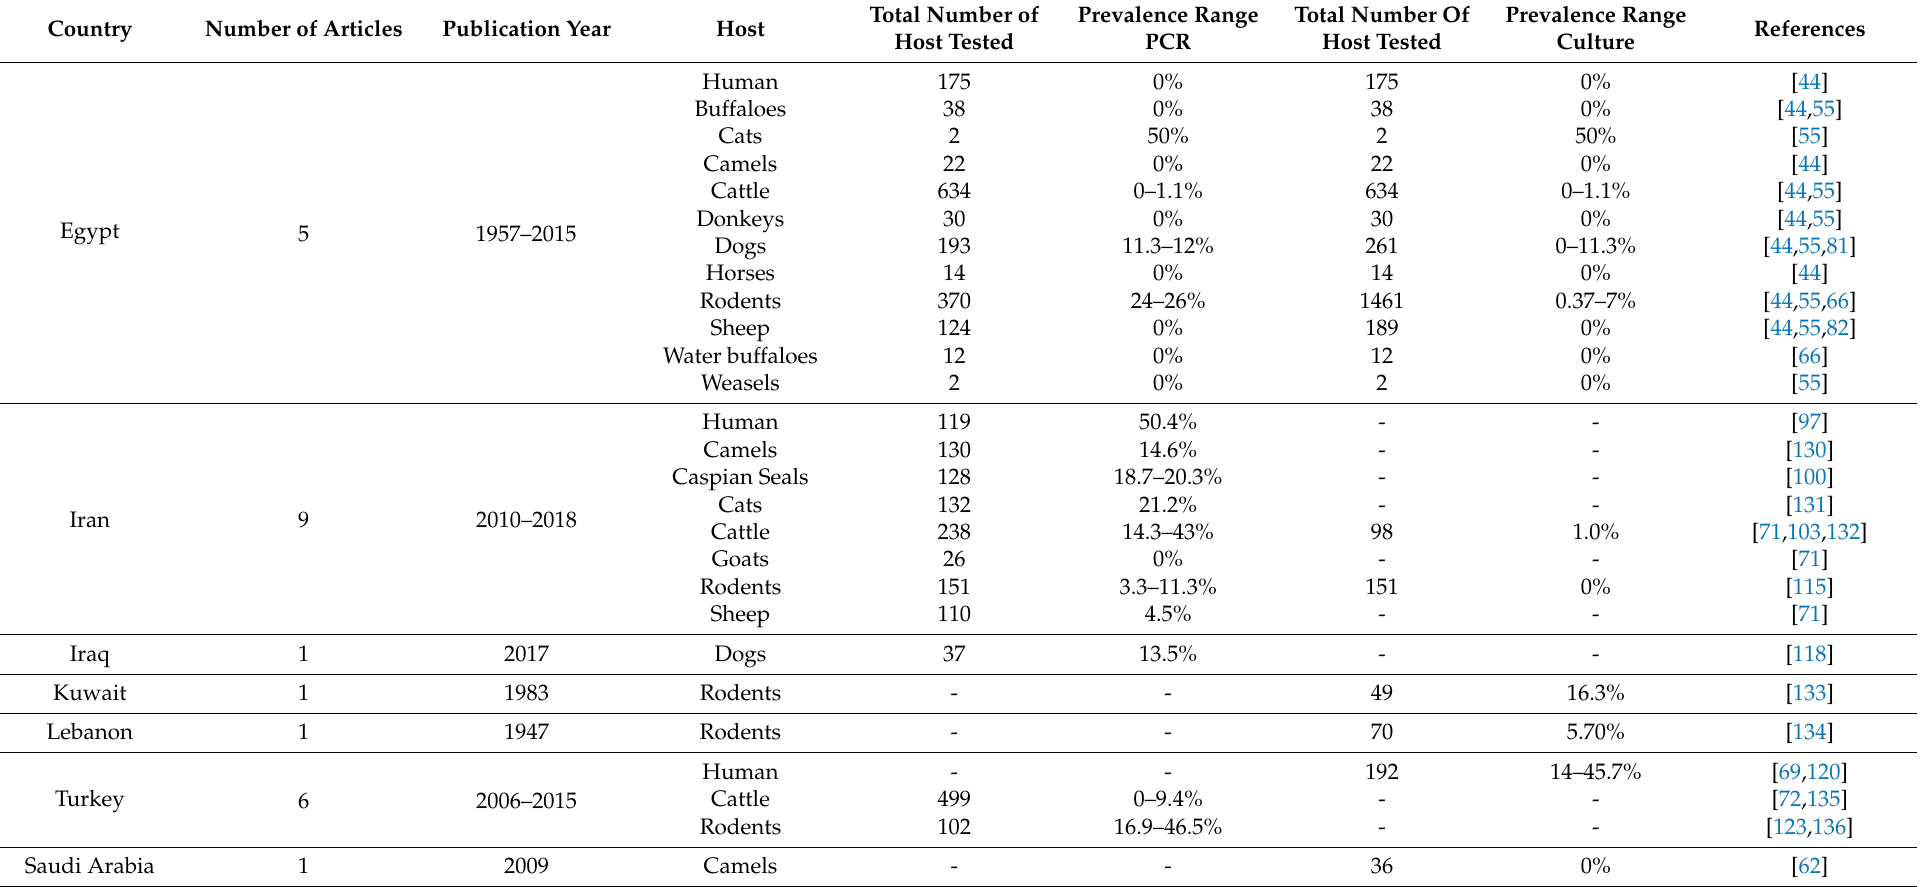
Table 2. Summary of Leptospira prevalence in the Middle East according to the test performed (PCR or culture) and the country from which the sampling originated.